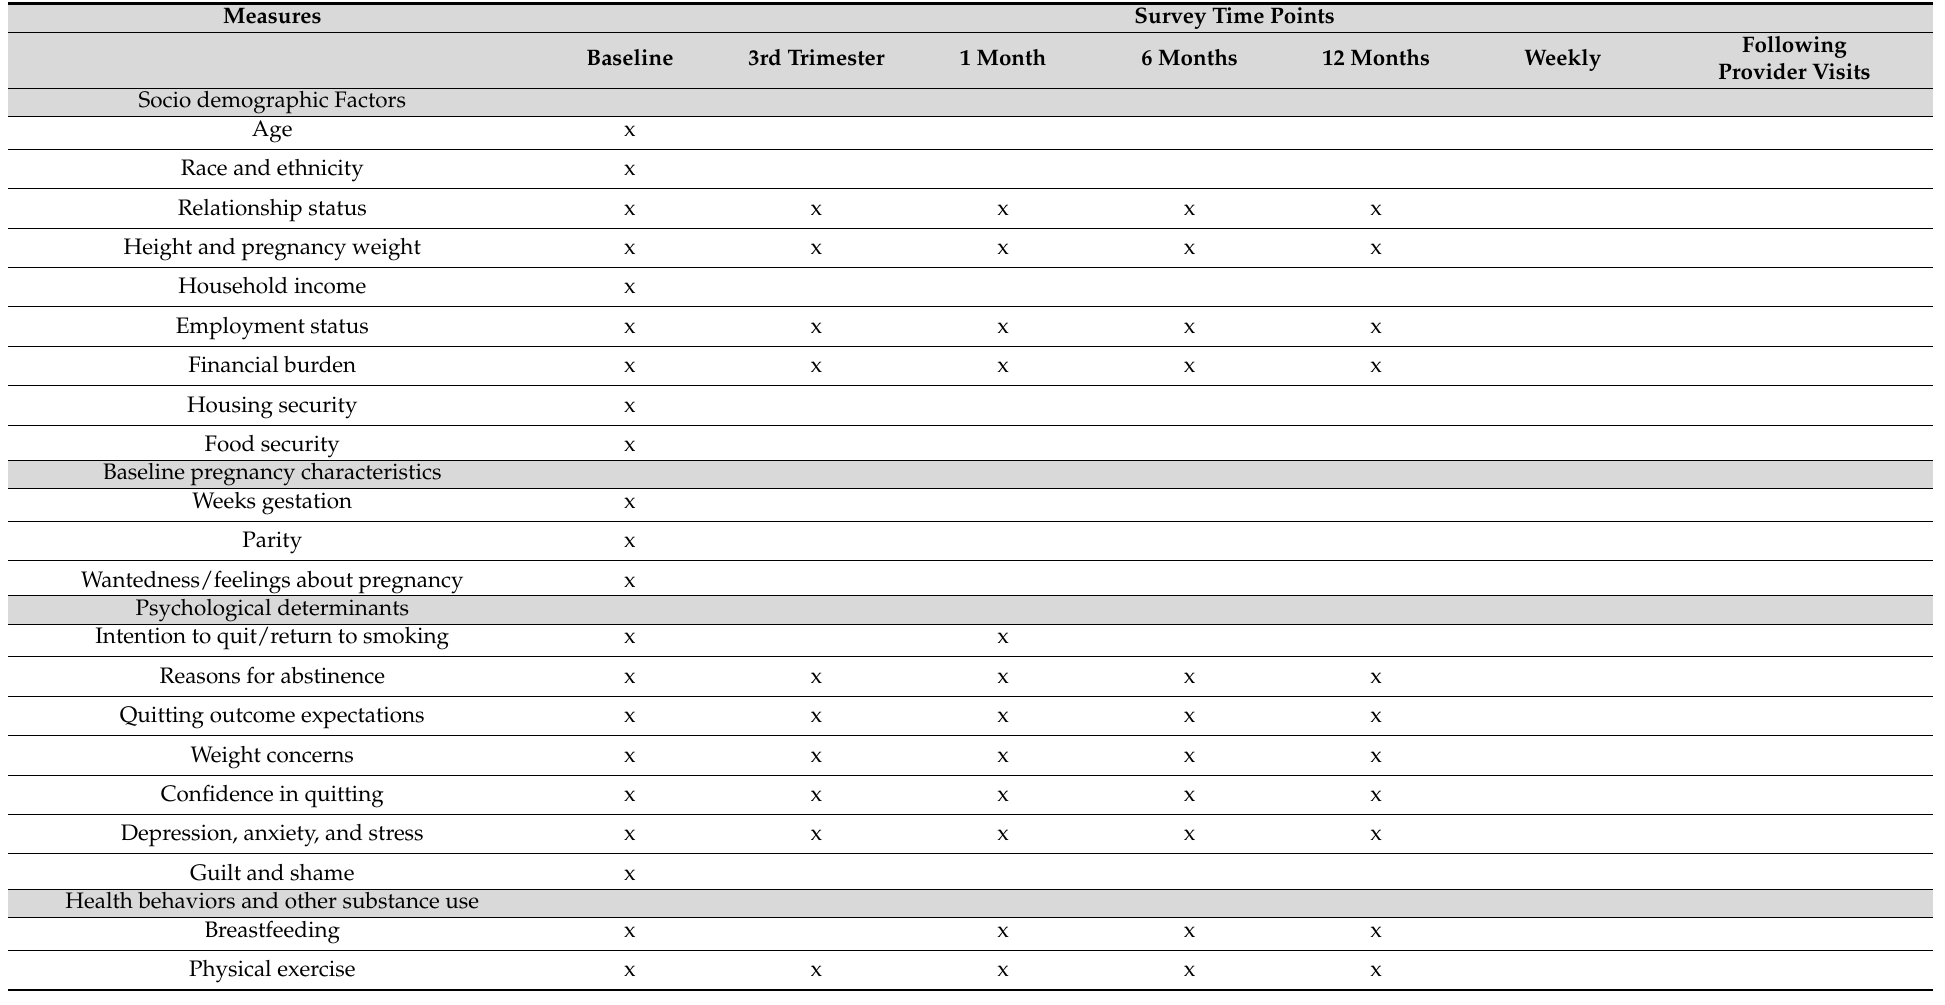
Table 1. Msgs4Moms’s cohort measures and assessment